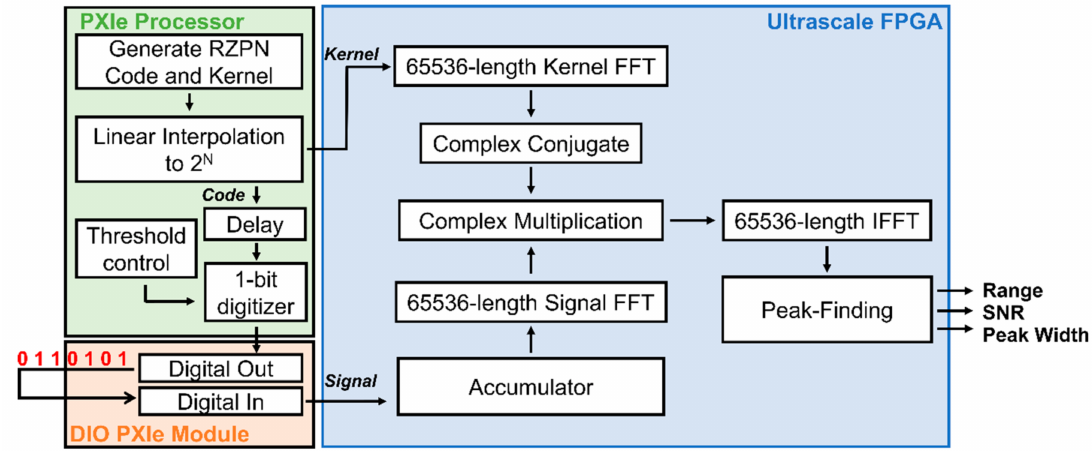
Figure 18. Simplified block diagram of real-time processing breadboard. All modules were housed in an NI PXIe chassis and data passed between modules occurred over the